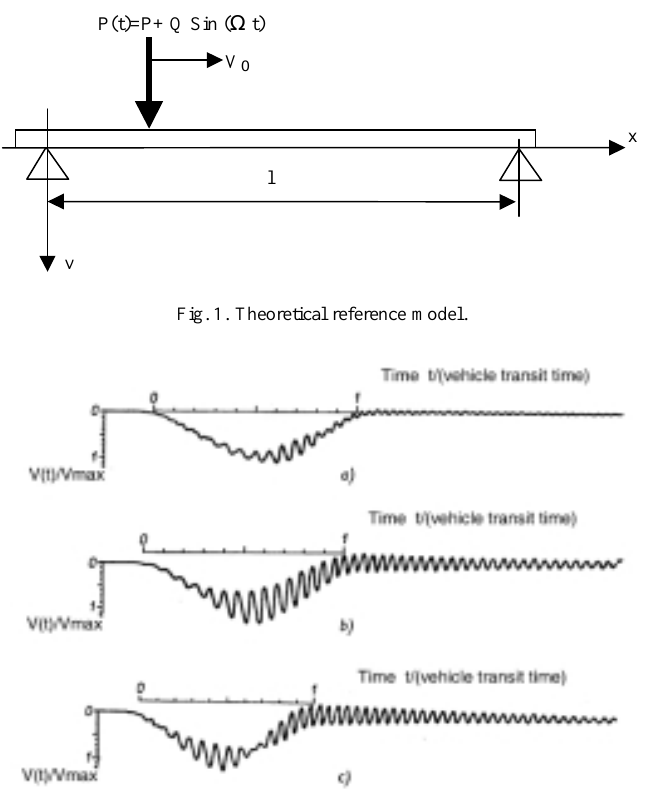
Fig. 1. Theoretical reference model.